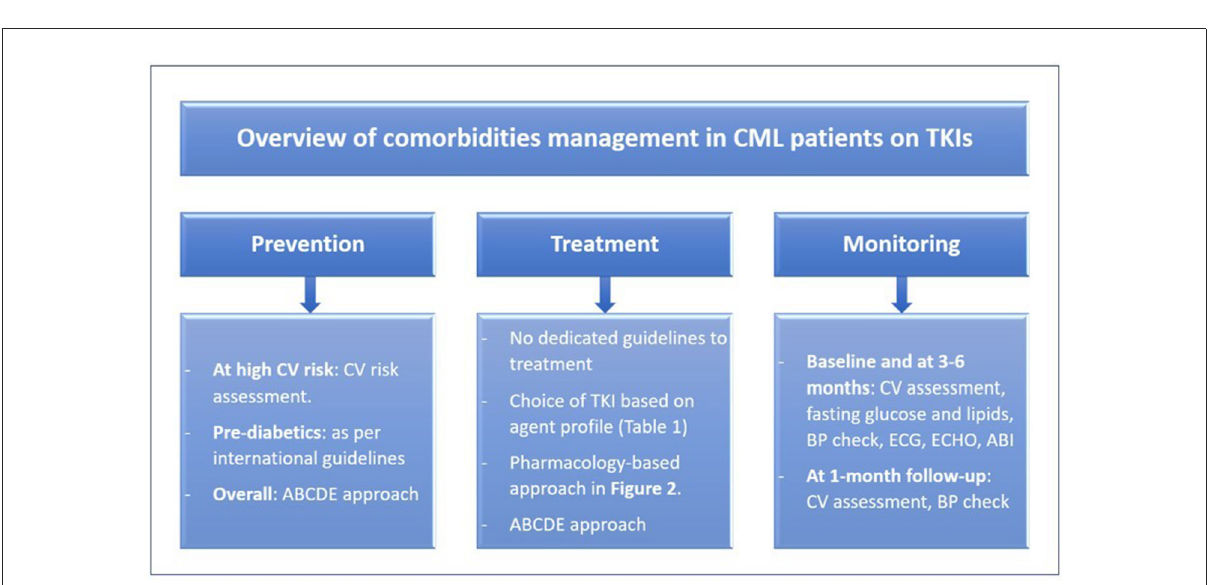
FIGURE1 Overview of comorbidities management in CML patients on TKIs. ABCDE, assessment of risk, antiplatelet therapy, BP management, cholesterol management, cigarette/tobacco cessation, diet and weight management, diabetes prevention and treatment, and exercise; ABI, ankle-brachial index; BP, blood pressure; CML, chronic myeloid leukemia; CV, cardiovascular; ECG, electrocardiogram; ECHO, echocardiogram; TKIs, tyrosine kinase